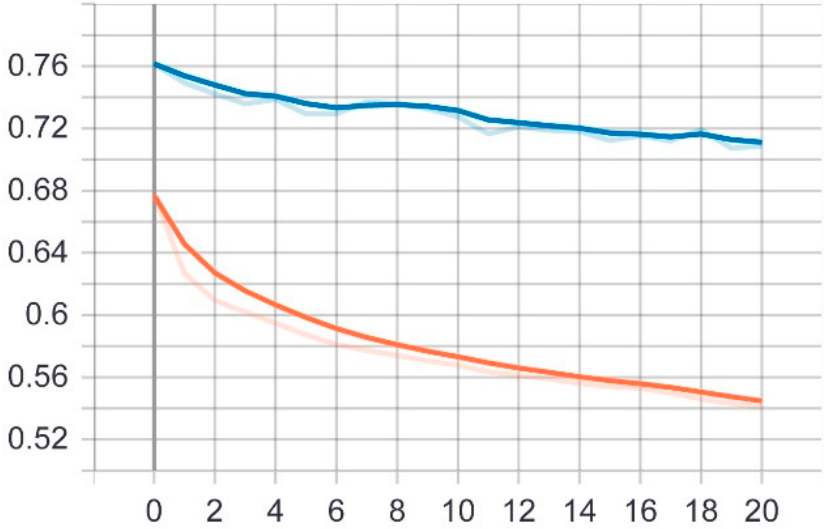
Figure 10. Accuracy (red line) and validation (blue line) loss curves of the second model over 20 epochs.